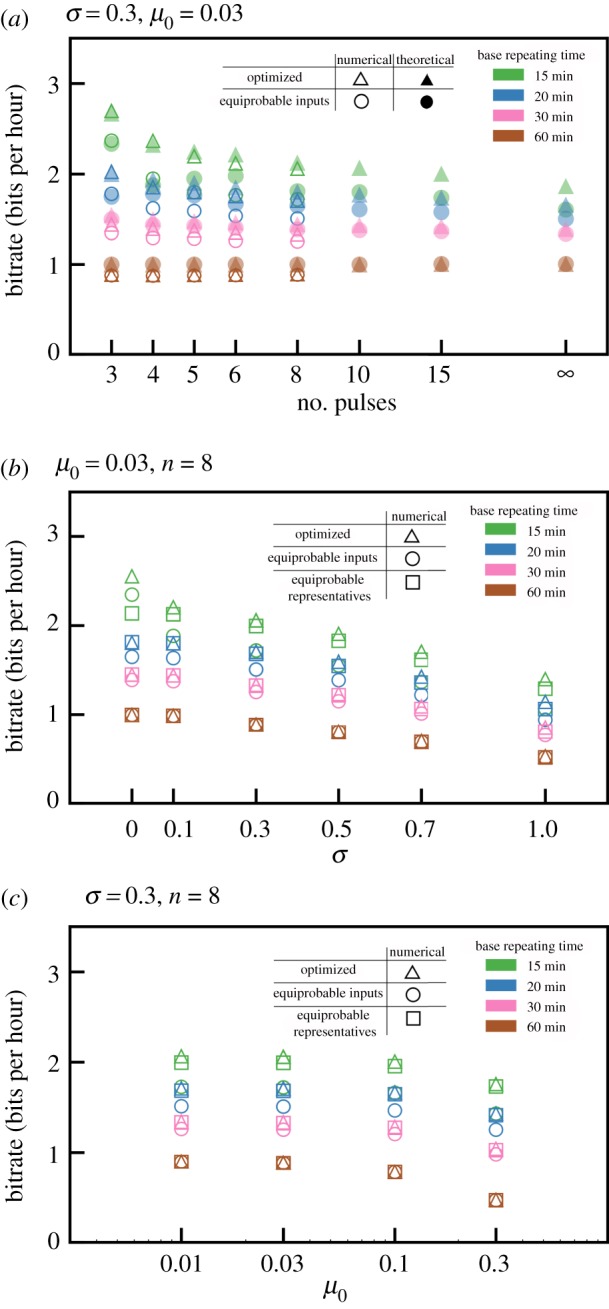
(a) Information transmitted per hour for moderate noise for different carrying frequencies ϕ = 1/T, where T = 15, 20, 30, 60 min. MI was calculated as follows: empty triangles—numerically optimized; solid triangles—optimized, i.e. log2(K); empty circles—numerically assuming equal probabilities of all input sequences; solid circles—theoretically assuming equal probabilities of all input sequences. (b) Influence of noise on transmitted information. (c) Influence of additive noise on transmitted information. In (b) and (c) MI was calculated numerically as follows: triangles—maximized; circles—assuming equal probabilities of all group representatives; squares—assuming equal probabilities of all input sequences.